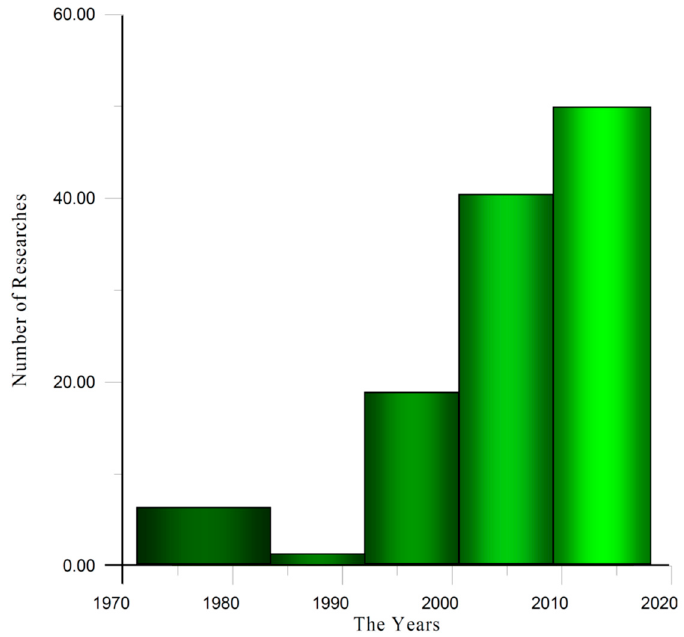
Figure 15. The number of published researches (at intervals of five years) through the period 1971 to 2017.